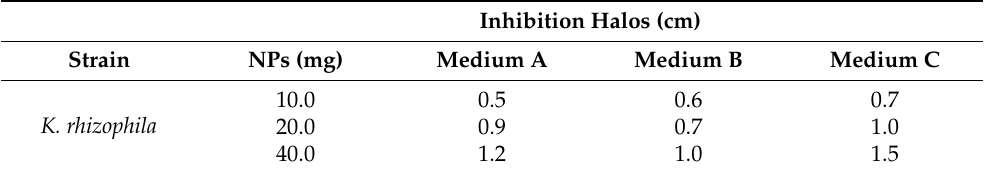
Figure 18. AgNPs’ effect against E. coli and K. rhizophila. Panel ( a ) E. coli in the presence of a AgNp solution containing 0.04 mg (spot B), 0.08 mg (spot A), or 0.16 mg (spot C). Panel ( b ) K. rhizophila in the presence of a AgNp solution containing 0.04 mg (spot C1), 0.08 mg (spot C2), or 0.16 mg (spot C3). Controls: 40 µL distilled water (spot B1) and CFS without AgNPs (spot B2). Table 3. Antimicrobial activity of SeNPs against K. rhizophila . Table 3. Antimicrobial activity of SeNPs against K. rhizophila .